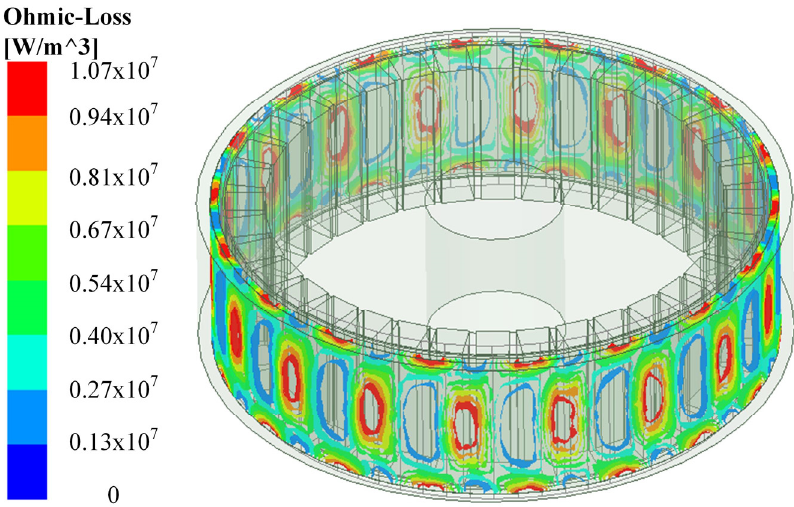
Figure 12. Ohmic loss distribution in the copper rings.